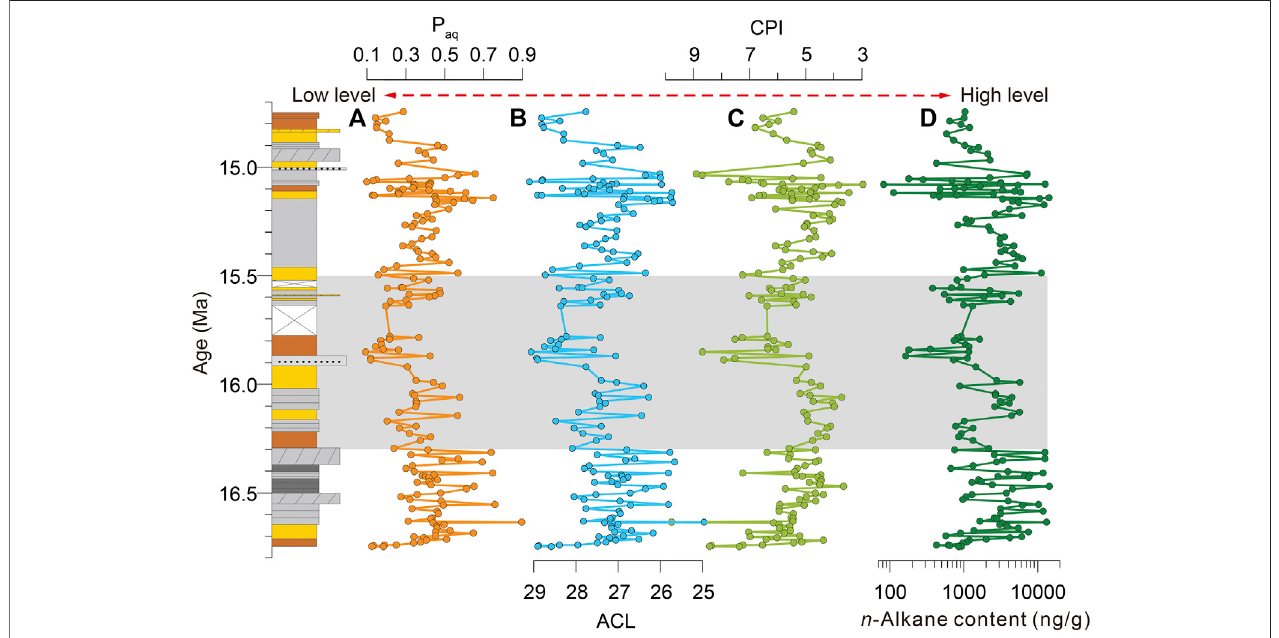
FIGURE3 | The litho-stratigraphyand records ofn-alkane indices, P aq (A) , CPI (B) , and ACL (C) , together with the n-alkane content (D) , in theLunporipro fi le. The greybar marks the interval of relatively low lake level. The legend of the stratigraphic column refers to that in Figure 2 .